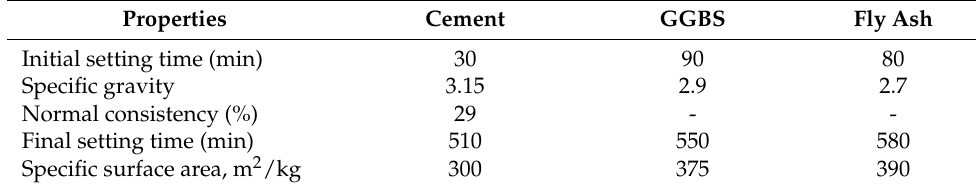
Table 2. Physical properties of the used materials.